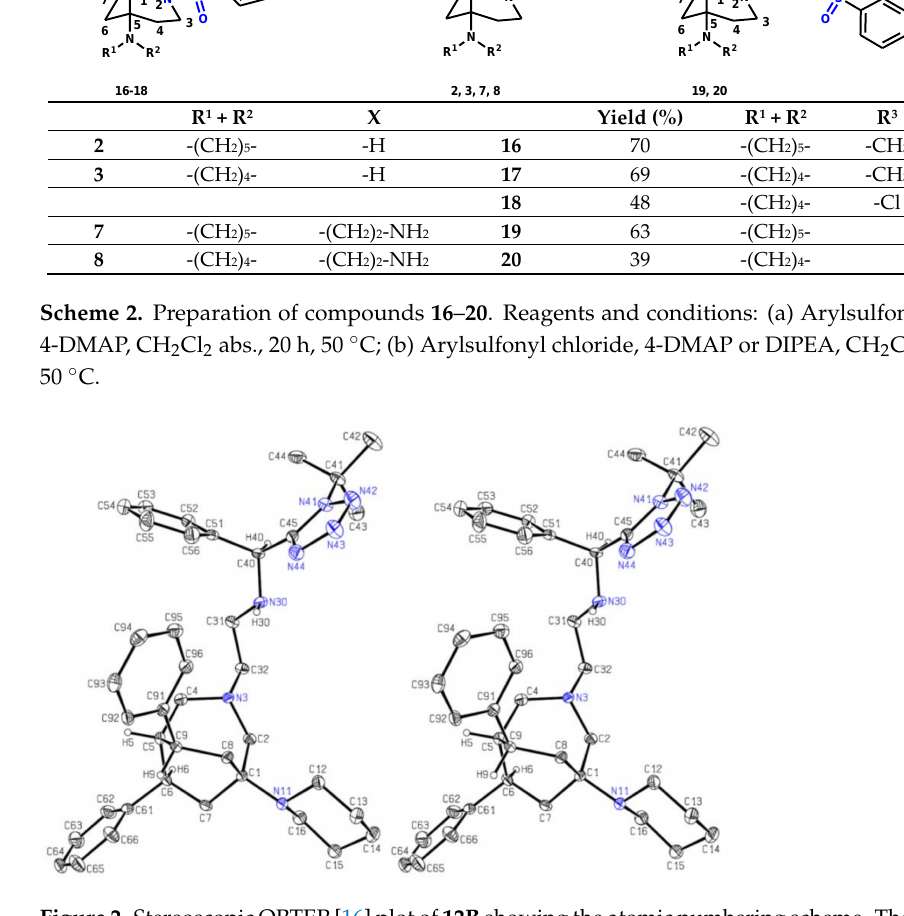
Figure 2. Stereoscopic ORTEP [16] plot of 12B showing the atomic numbering scheme. The probability ellipsoids are drawn at the 50% probability